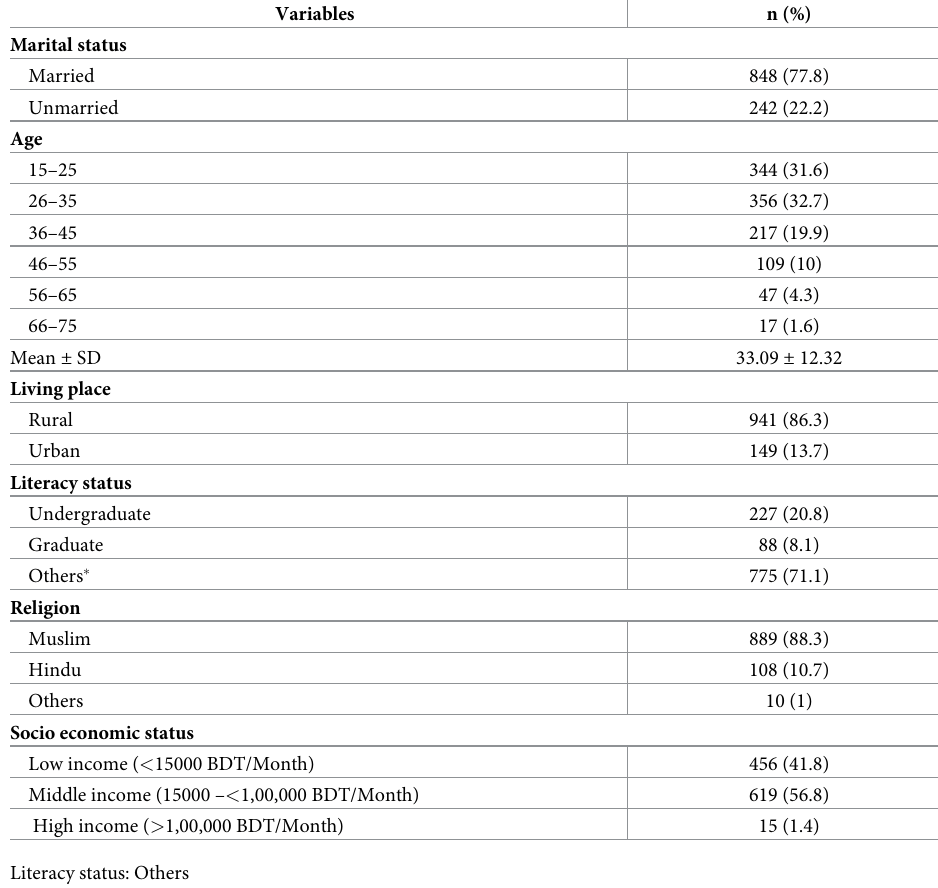
Table 1. Socio-demographic characteristics of female respondents (n =